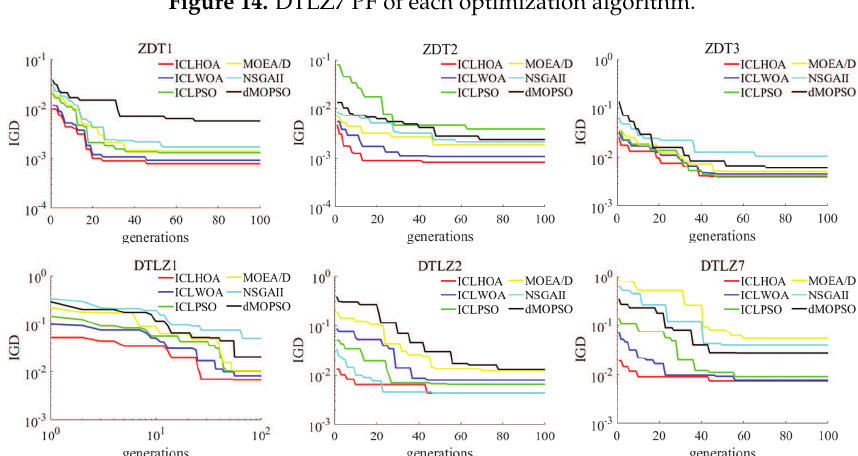
Figure 14. DTLZ7 PF of each optimization algorithm.